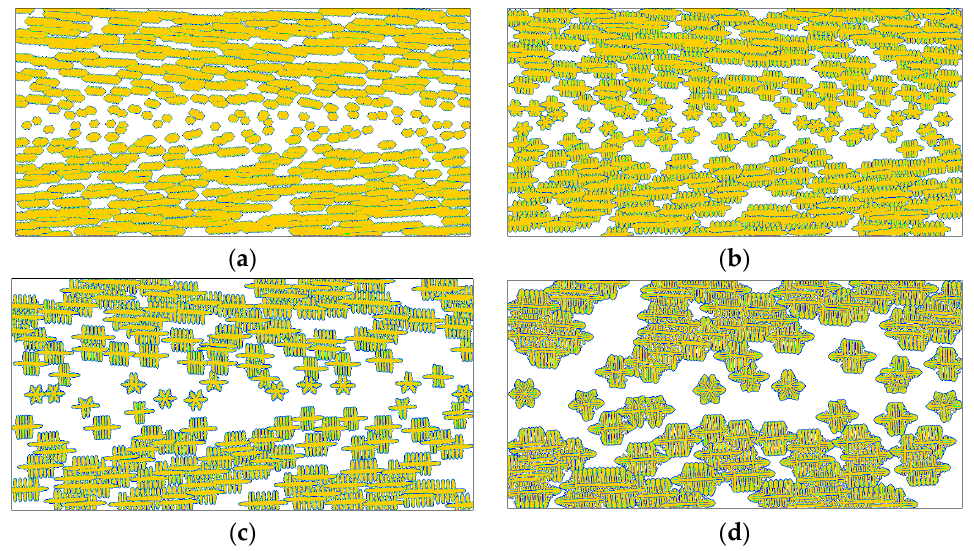
Figure 9. Simulated crystallization morphologies in the crystal order parameter field for the flow strength ˆ γ “ 30 and anisotropy strength ε = 0.03 at different crystallization temperatures: ( a ) T c = 180 C, t = 200; ( b ) T c = 190 °C, t = 400; ( c ) T c = 200 °C, t = 600; ( d ) T c = 210 °C, t = 1000. Here the time instants are chosen to ensure the results show similar sizes of crystallized regions.